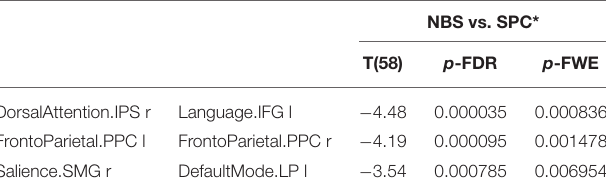
TABLE 8 | The decreased functional connectivity in older women observed only in NBS analysis, not found in the SPC